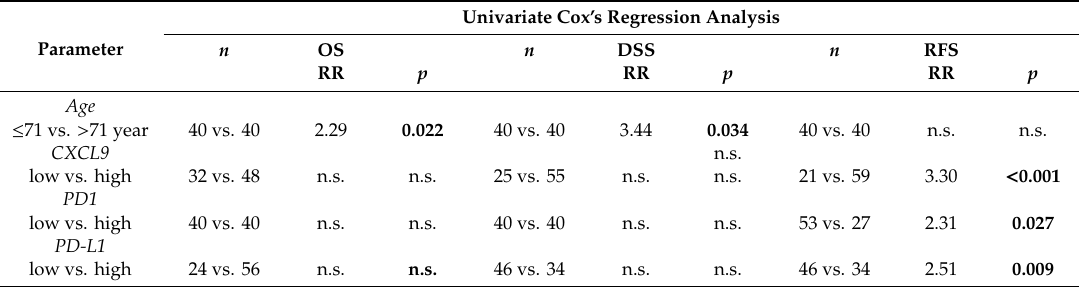
Table 3. Univariate Cox’s regression analysis for the association of age and CXCL9, PD1 and PD-L1 mRNA with prognosis.